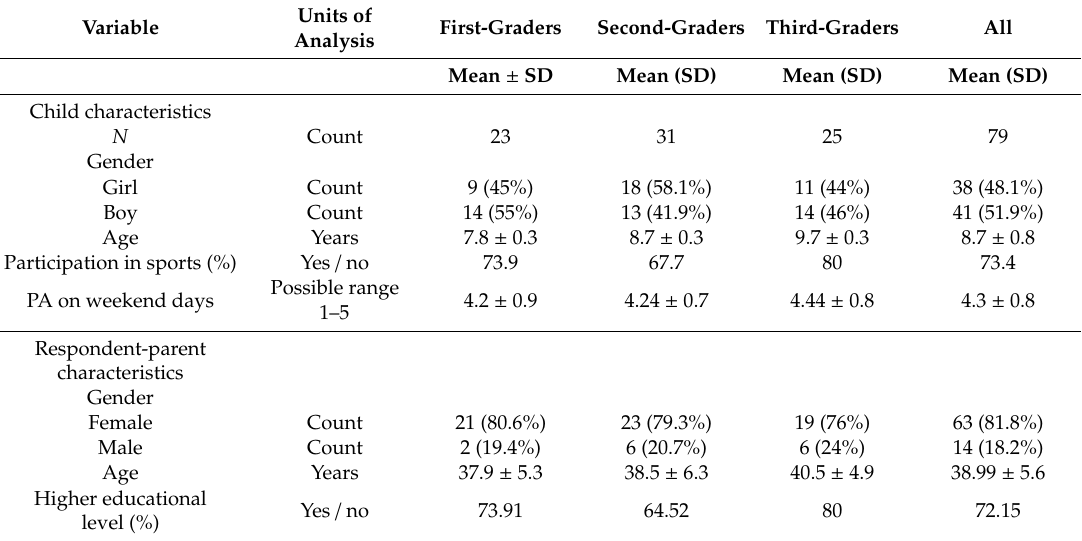
Table 1. Descriptive statistics for children participating in the focus groups and their